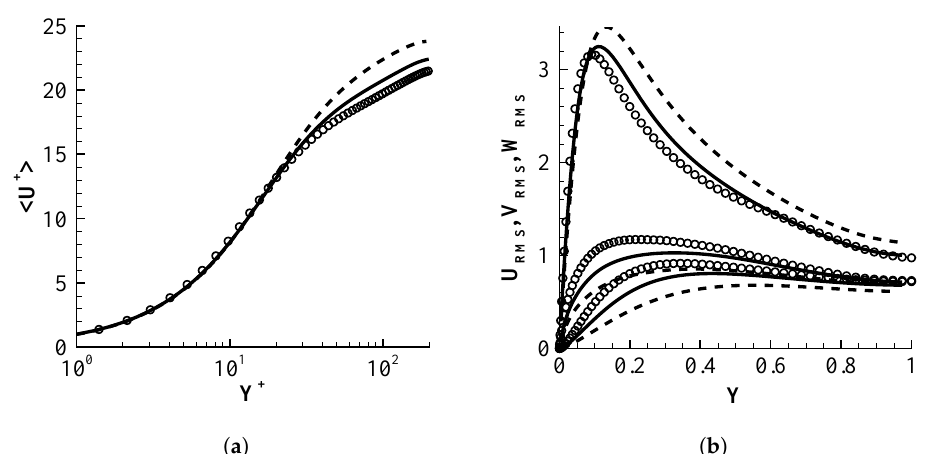
Figure 2. ( a ) Mean velocity profiles in wall units and ( b ) RMS velocity profiles in wall coordinates.